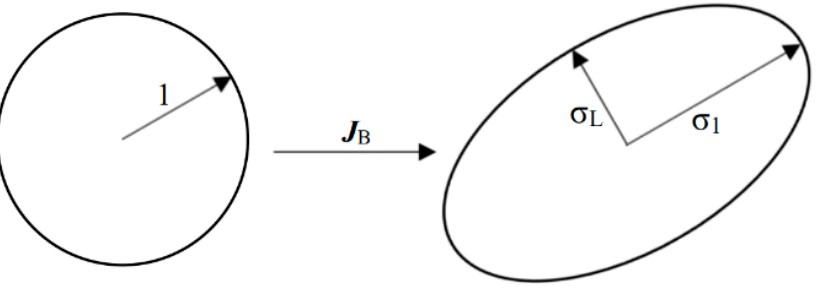
Figure 3. Geometric significance of singular values.